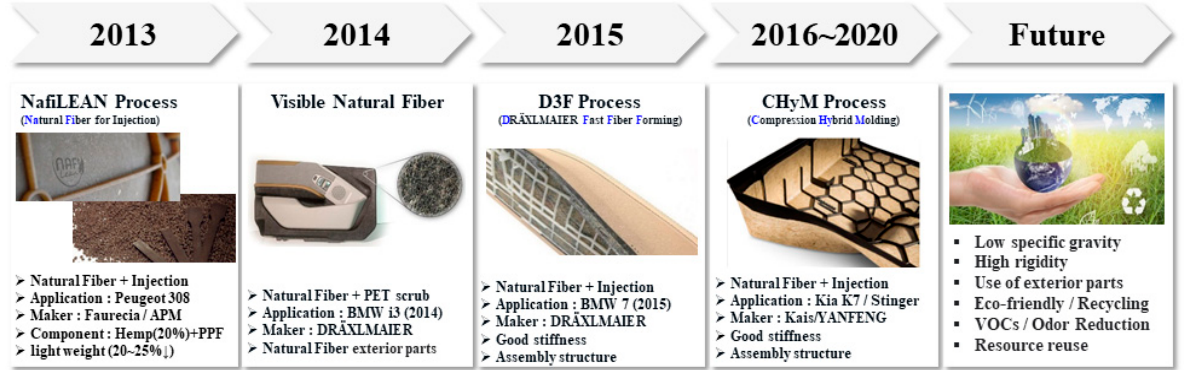
Figure 1. Eco-friendly and lightweight trend of global automobile parts.